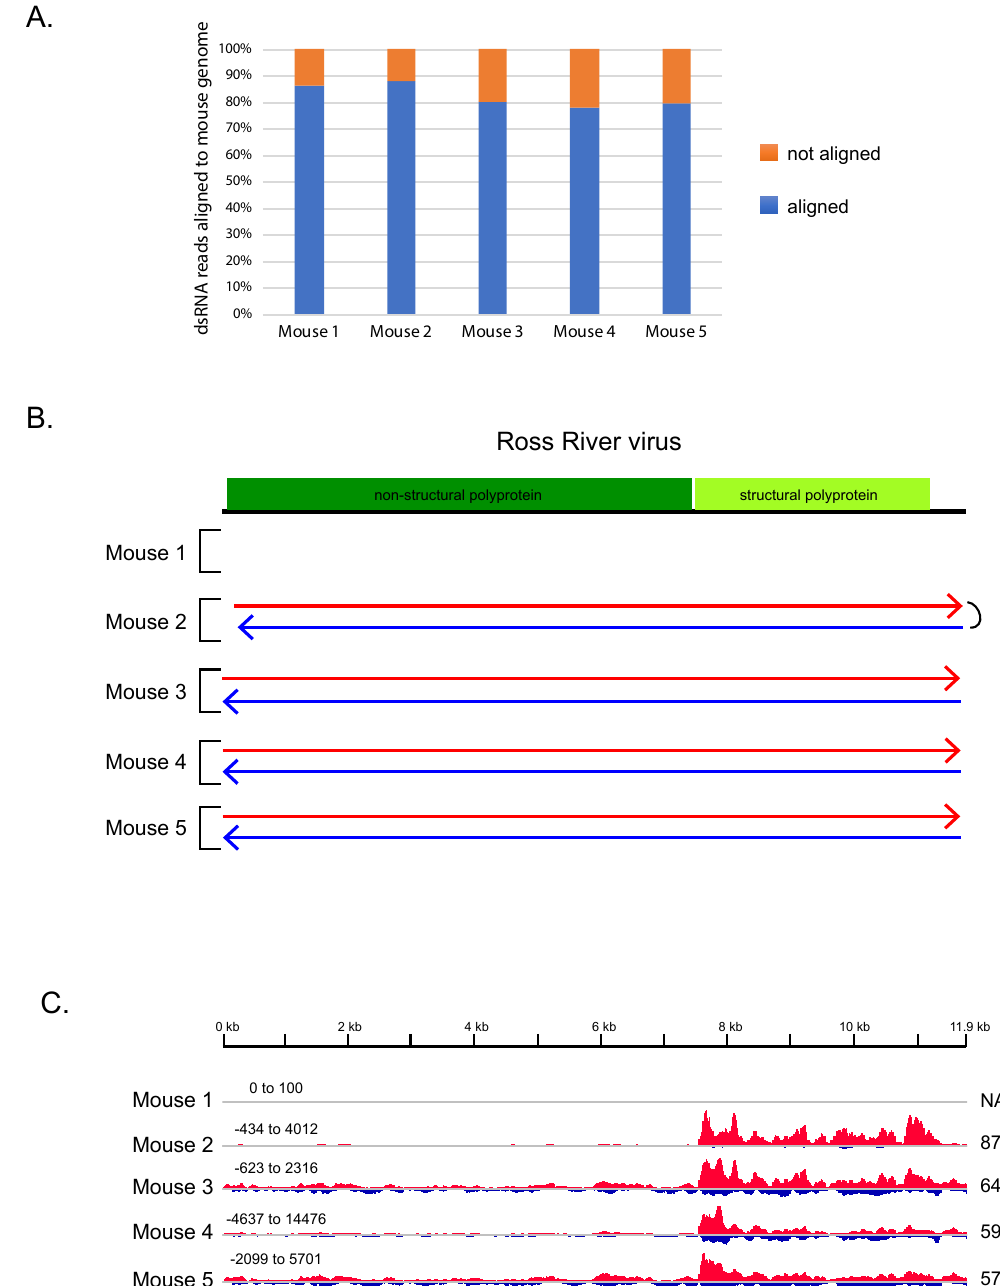
Figure 2. dsRNA-Seq detects viral infection in infected mice. ( A ) Percentage of dsRNA-Seq reads that aligned to the mouse genome; ( B ) Ross River virus with protein coding regions indicated in colored boxes. Arrows indicate the alignment of contigs assembled from dsRNA-Seq reads from mouse samples. Contigs representing the positive strand of the virus are in red; negative strand in blue. The mouse 2 sample contained a single contig that represented both the positive and negative strand of the virus indicated by the link on the right; ( C ) bedgraphs of dsRNA-Seq reads that aligned to Ross River virus genome from mouse samples. Height indicates the base count at each position along the Ross River virus sequence. Red indicates counts on the positive strand. Blue indicates counts on the negative strand. The percentage of the total reads that mapped to the Ross River virus that aligned to the positive strand is indicated on the right. Note: The bedgraphs have not been scaled relative to total number of dsRNA-Seq reads in each sample. Each read set was scaled individually, scale is indicated at top left for each